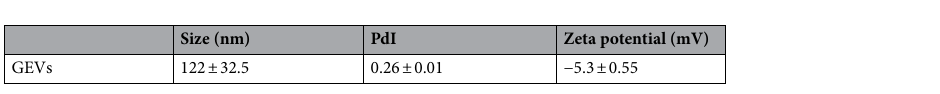
Table 1. Physicochemical properties of GEVs. The data are expressed as the mean ± S.D. (n =